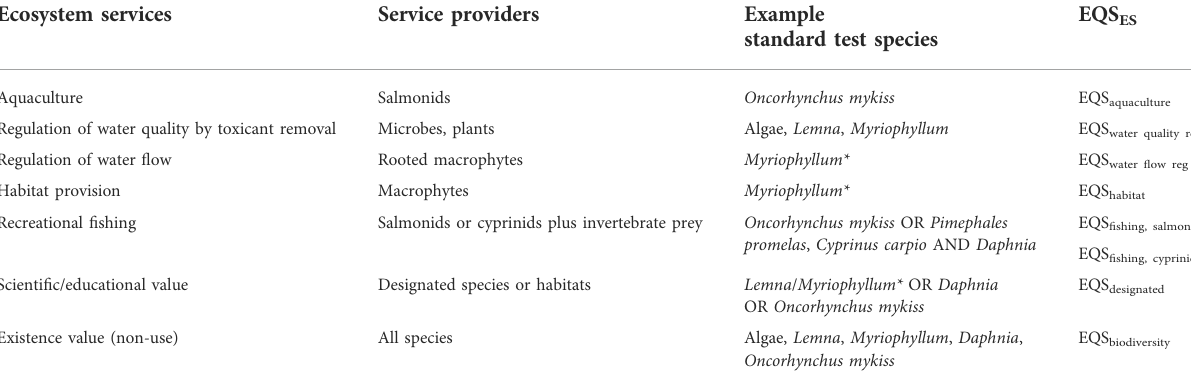
TABLE 3 Exemplar test species for biotic ecosystem services in Table 2 with corresponding EQS nomenclature. Exemplar ecosystem services include taxonomic groups not currently considered in EQS setting (e.g. regulation of water quality by microbes) and groups receiving limited coverage (e.g. regulation of water fl ow by rooted macrophytes). * algae used as surrogate primary producers if no macrophyte data are